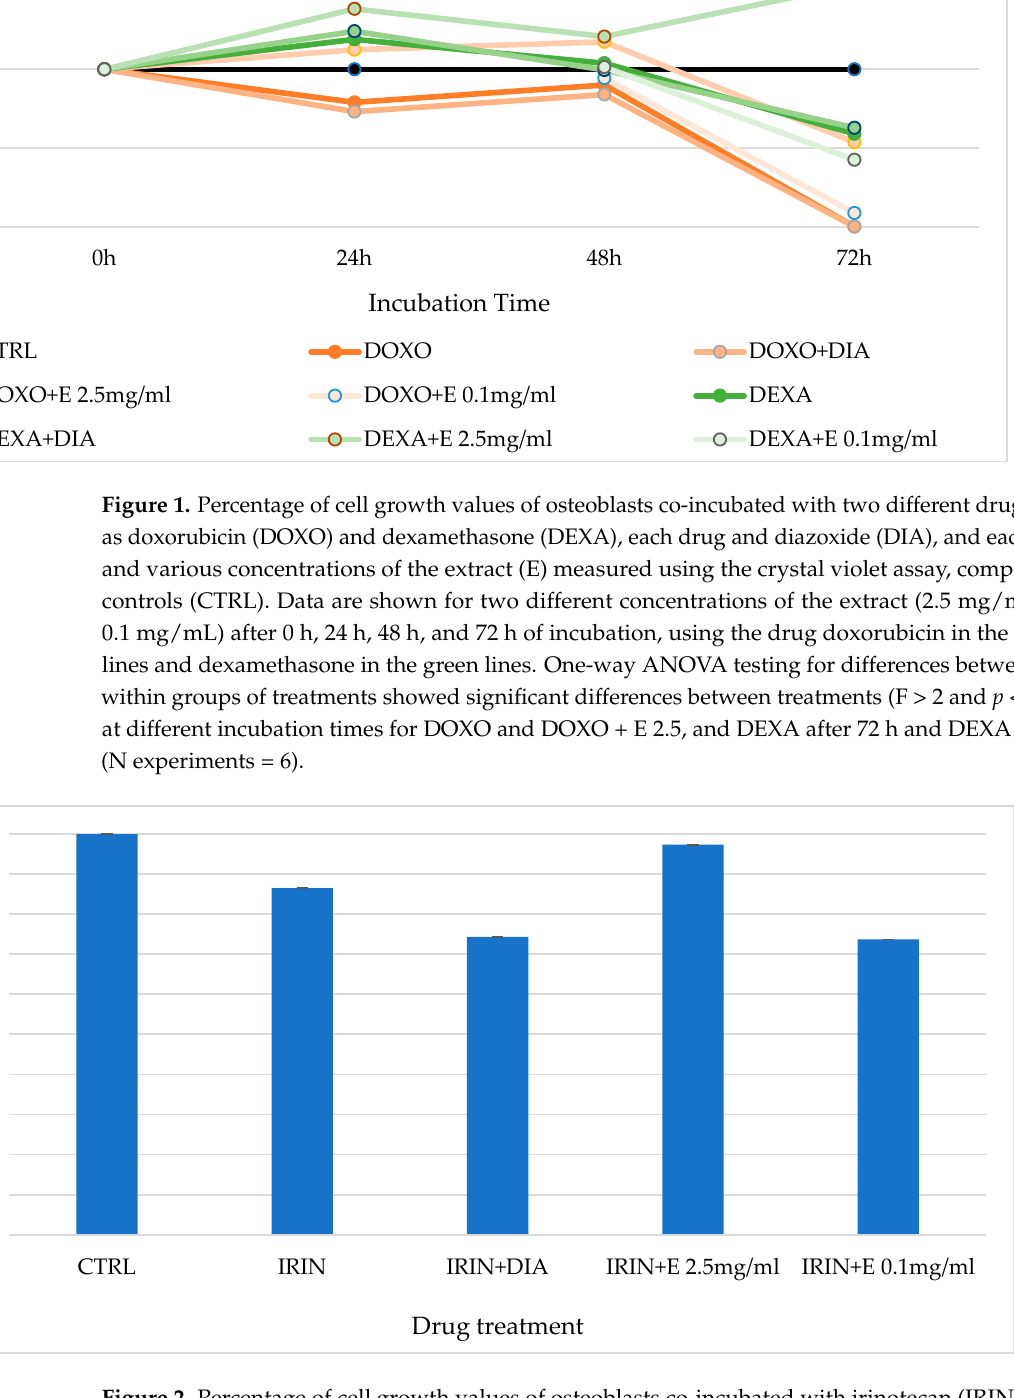
Figure 2. Percentage of cell growth values of osteoblasts co-incubated with irinotecan (IRIN) alone, irinotecan and diazoxide (DIA), and irinotecan and two different concentrations of the extract (E) measured using the crystal violet assay, compared to control (CTRL). Data are shown for two different concentrations of the extract (2.5 mg/mL and 0.1 mg/mL) after 72 h of incubation. One-way ANOVA testing for differences between and within groups of treatments showed significant differences between treatments (F > 1.8 and p < 0.05) for IRIN and IRIN + E 2.5 (N experiments =